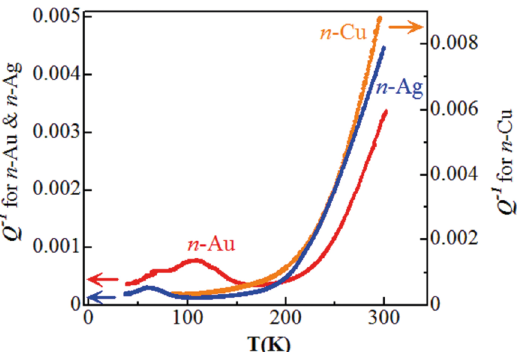
Figure 5. Comparison of the internal friction spectrum between n -Ag (blue), n -Au (red), and n -Cu